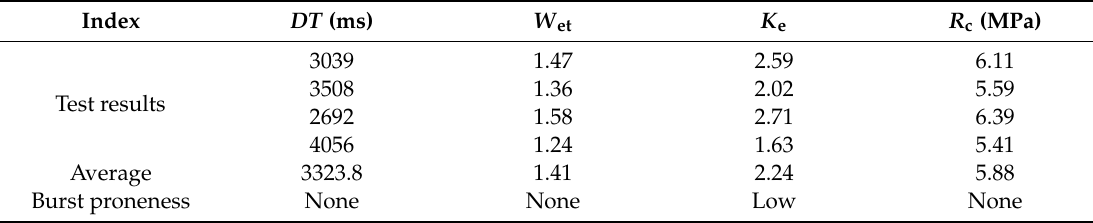
Table 8. Test result and coal burst proneness of TJH coal